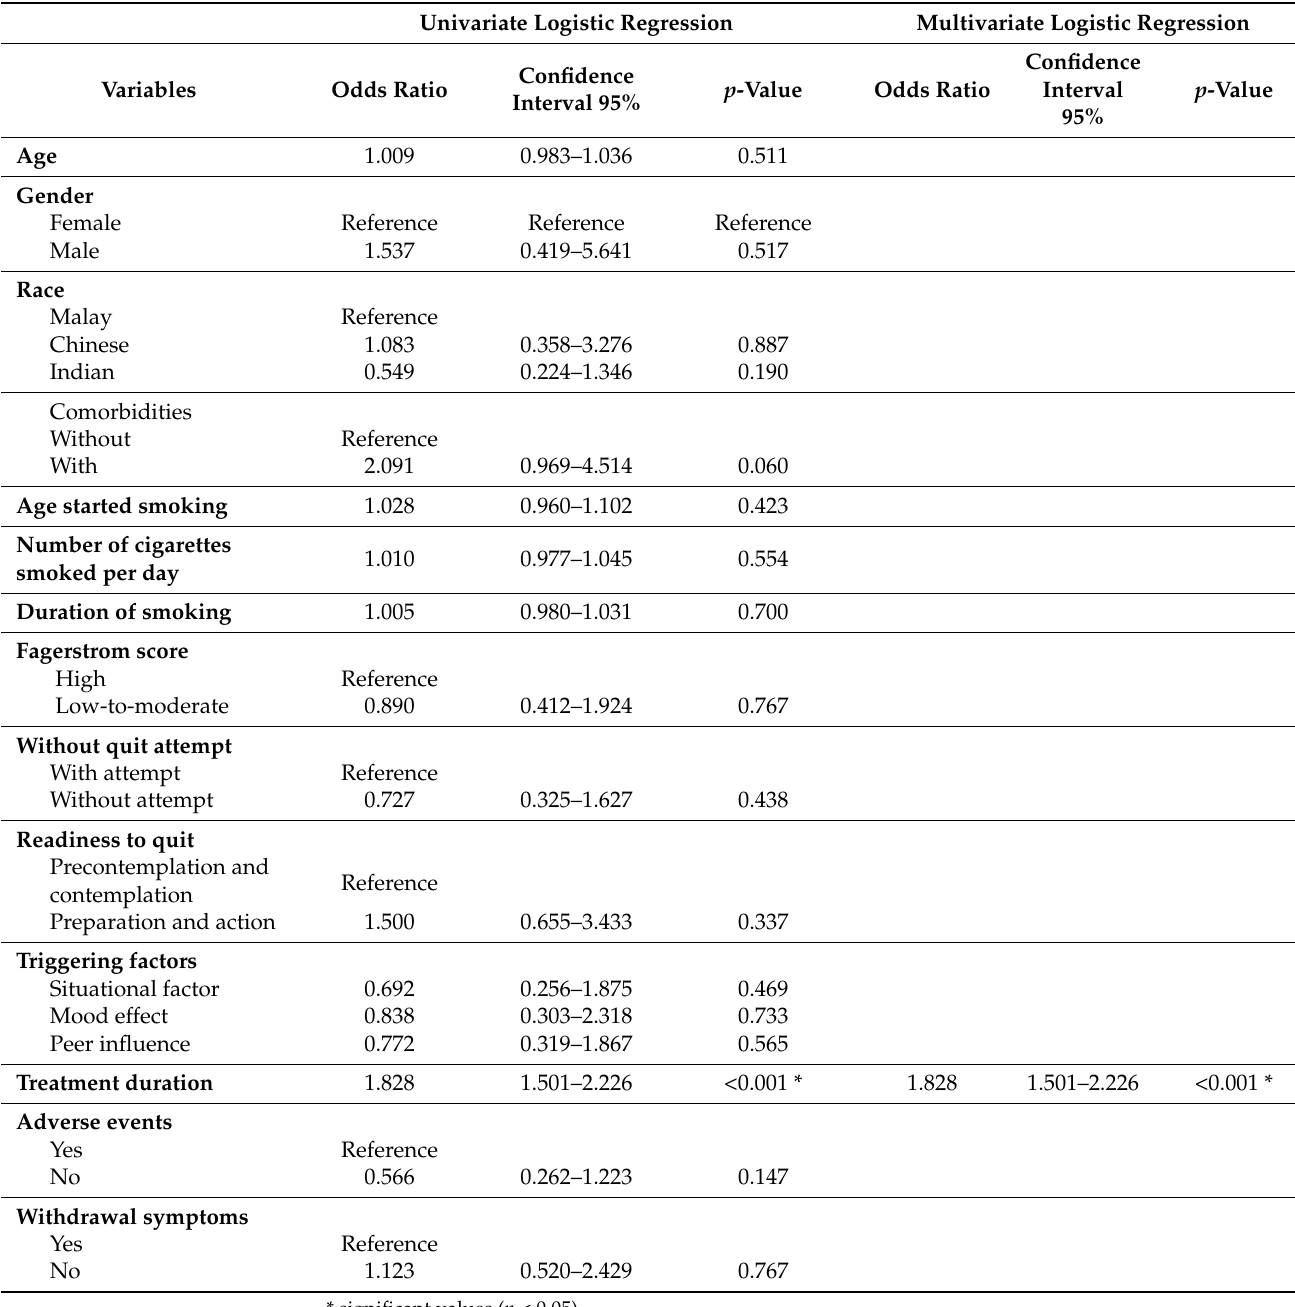
Table 5. Univariate and multivariate logistic regression analysis on predicting factors of smoking